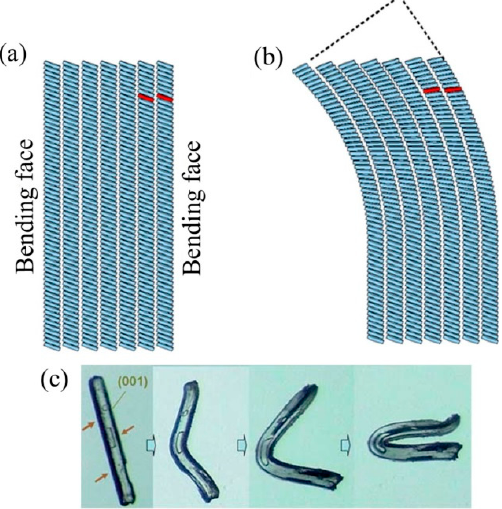
Figure 4. The plastic bending model of organic molecular crystals. ( a ) An undeformed crystal (half sectional view) where the weakest interactions represent white spaces between rows of stacks; ( b ) a bent crystal where the relative movement of the disk is highlighted in red, with pronounced deformation in interfacial angles (dashed line); and ( c ) the bending of C6Cl6 crystal. (Reproduced with permission from Royal Society of Chemistry, Reference 59).